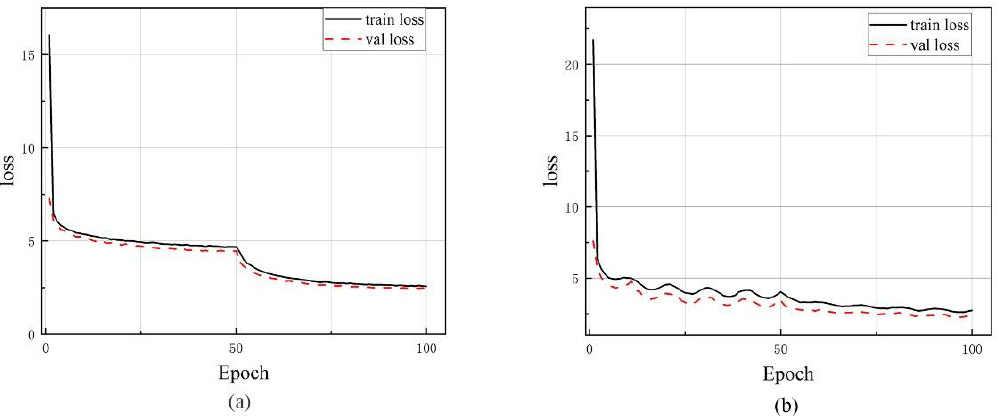
Figure 9. Loss function graph for different training methods. ( a ) The random initialization. ( b ) transfer learning.